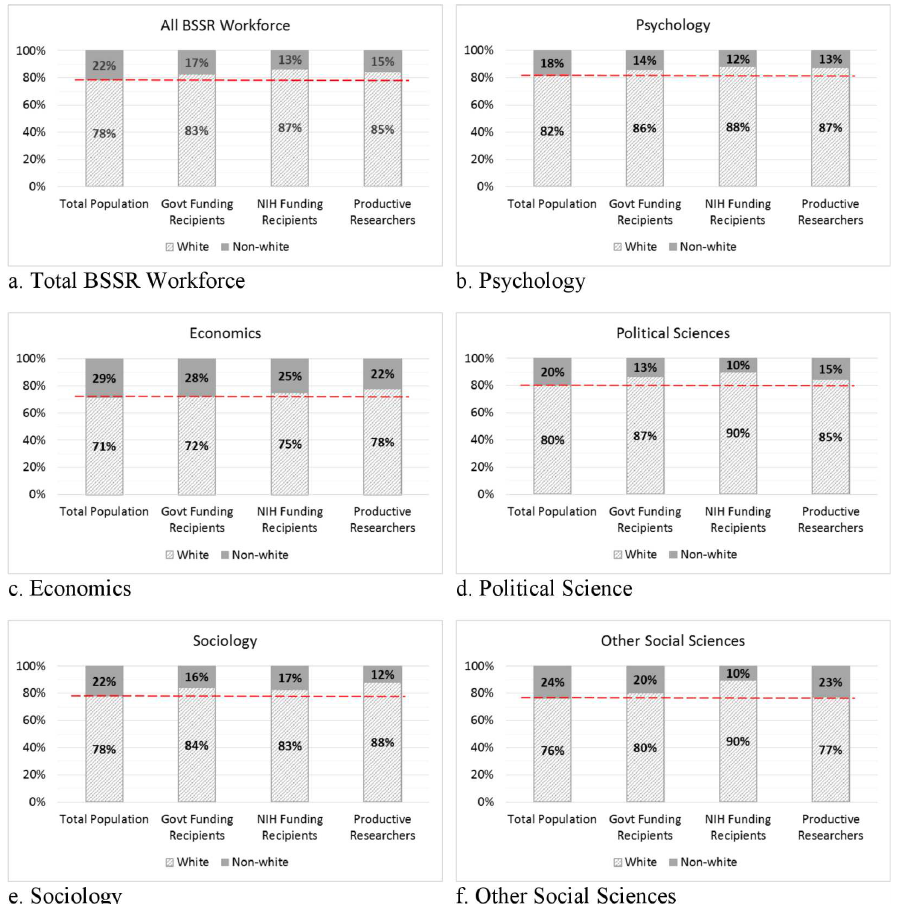
Fig 1. Racial/ethnic distribution of scientists in academic positions by major field. Source: SDR 2008 and 2013.